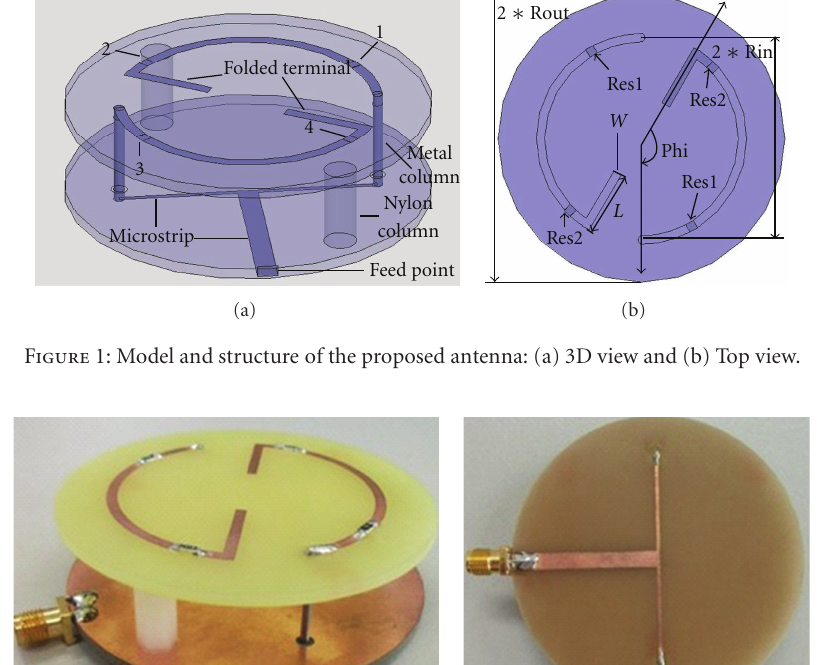
The antenna prototype is printed onto an FR4 substrate ( ε r = 4 . 4, tan δ = 0 . 02, thickness T = 2 mm). The optimized antenna have parameters of H = 15 mm, W = 2